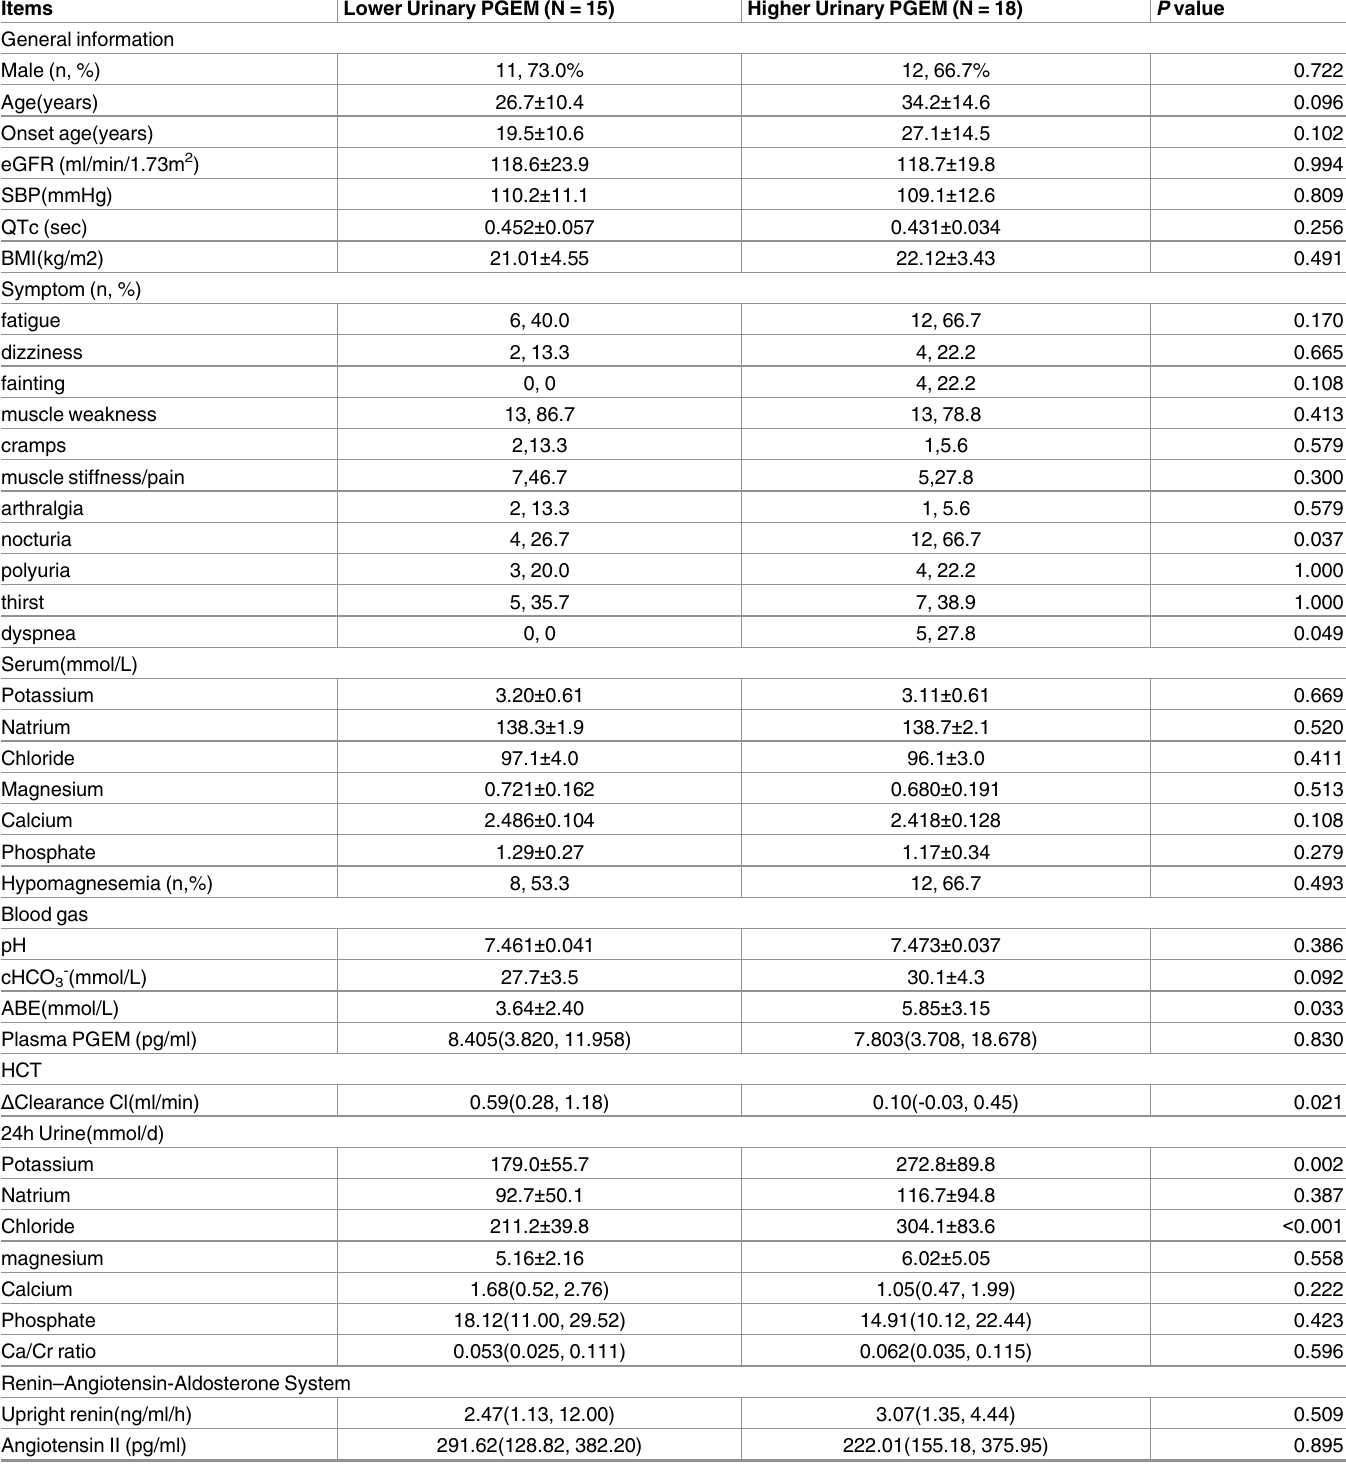
Table 3. Clinical data of patients with lower and higher urinary PGEM